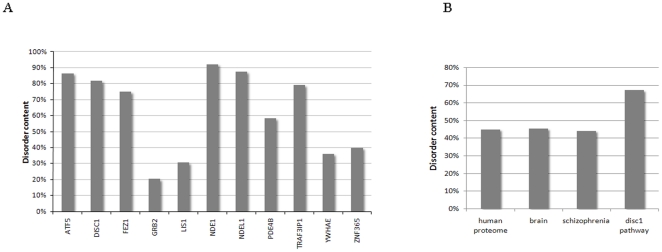
Prevalence of intrinsic disorder in the studied DISC1 pathway proteins, as measured by DisProt analysis.(A) Disorder content of the individual proteins of the DISC1 pathway (i.e. percentage of disordered residues/ total number of amino acids). (B) Disorder content of the DISC1 pathway proteins compared to human proteome (i.e. 20320 SwissProt proteins), a set of brain proteins (7160 sequences from GeneAtlas) and a set of schizophrenia candidate proteins (670 sequences from the Schizophrenia Gene Resource database). Overall, the DISC1 pathway proteins exhibit a higher abundance of intrinsically disordered residues, compared to the human proteome.